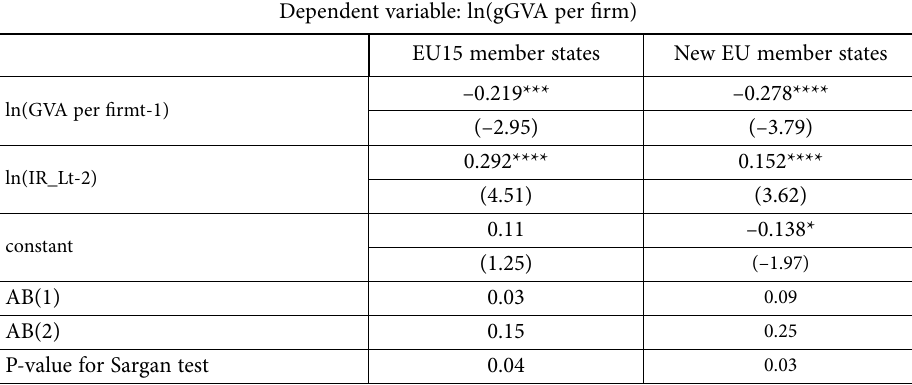
Table 3. Testing the beta convergence of gross value added in the case of Manufacture of computer, electronic, and optical products for EU15 and the new EU member states 1 (source: Authors calculation using STATA